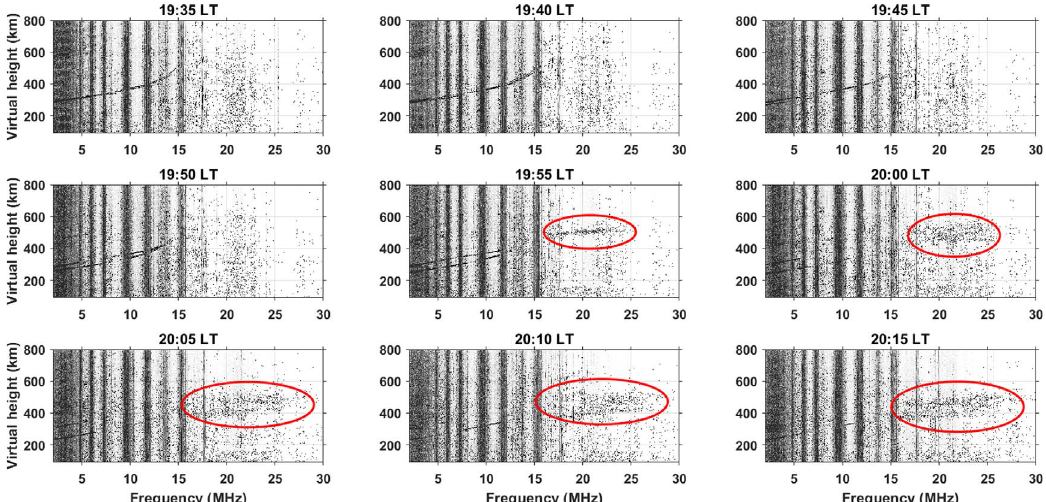
Fig. 3. Evolutions of ionograms (red ellipses represent the backscatter echoes beyond the foF2) recorded at CMU station on 13 March 2015.